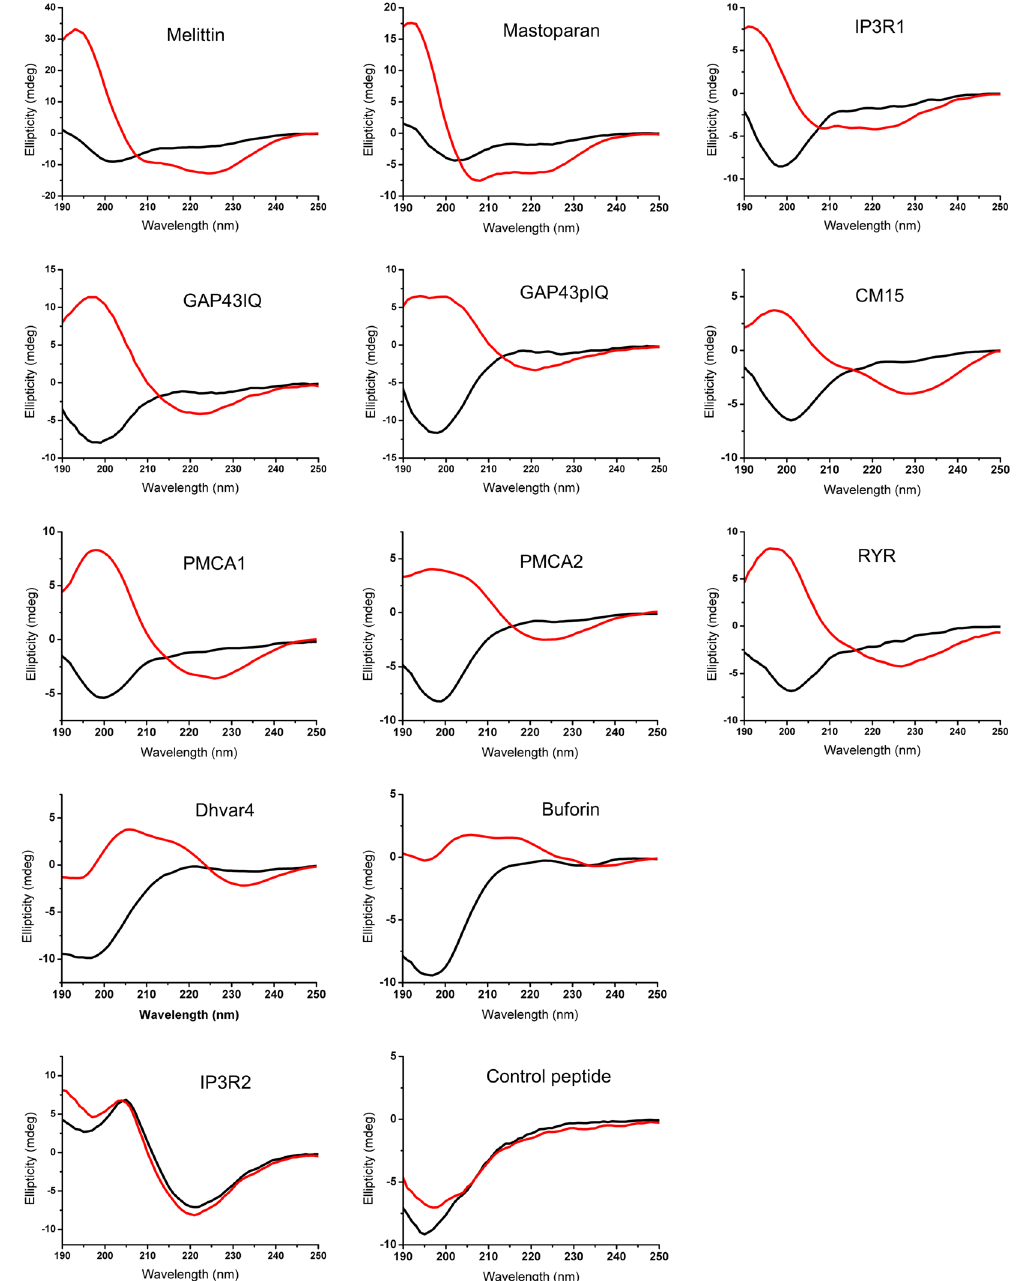
Figure 1. Far-UV CD spectra of the peptides in the absence (black) and presence (red) of LPA. Spectra were collected with and without 100 μ M LPA under low-salt conditions. The induced secondary structure is mainly helical for melittin (25 µ M), mastoparan (25 µ M) and peptide IP3R1 (36 µ M) (top row), rich in β -sheet for eight peptides (GAP43IQ (36 µ M), GAP43pIQ (36 µ M), CM15 (24 µ M), PMCA1 (21 µ M), PMCA2 (26 µ M), RYR (34 µ M), Dhvar4 (18 µ M), buforin (24 µ M); middle rows), while no remarkable change was detected for IP3R2 (36 µ M) and the control peptide (36 µ M) (bottom row). Note that ellipticity scales are